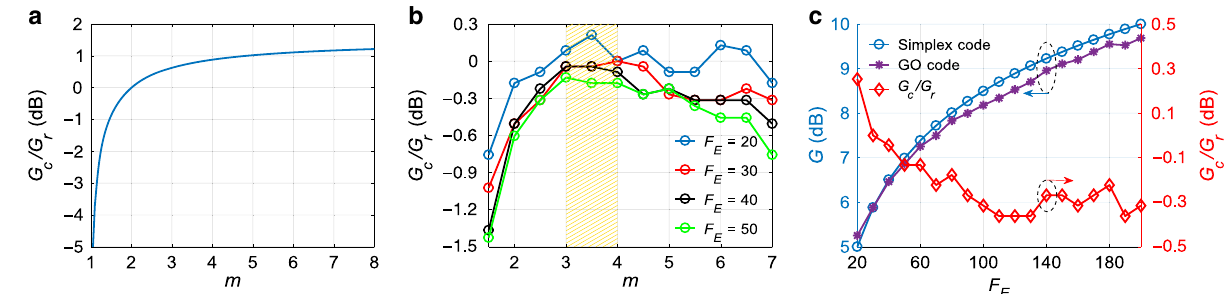
Fig. 2 Theoretical results of the coding gains in logarithmic scale. a Theoretical maximum and b genetic-optimised G c / G r as a function of m . c Coding gains of the genetic-optimised code and Simplex code (left-hand side vertical axis) and their difference (right-hand side vertical axis) as a function of the energy enhancement factor F E for m = 3.